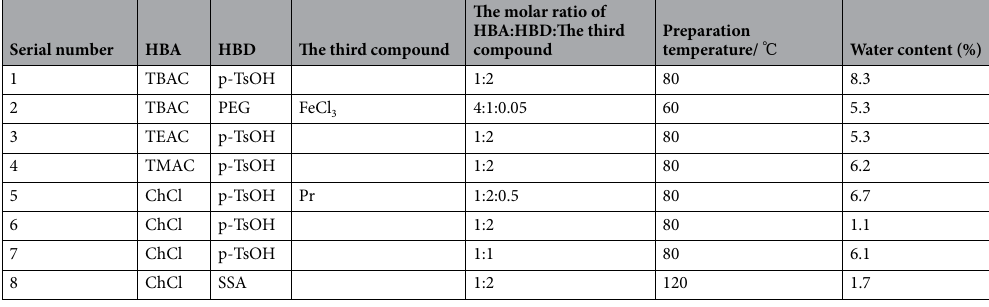
Table 2. Preparation of